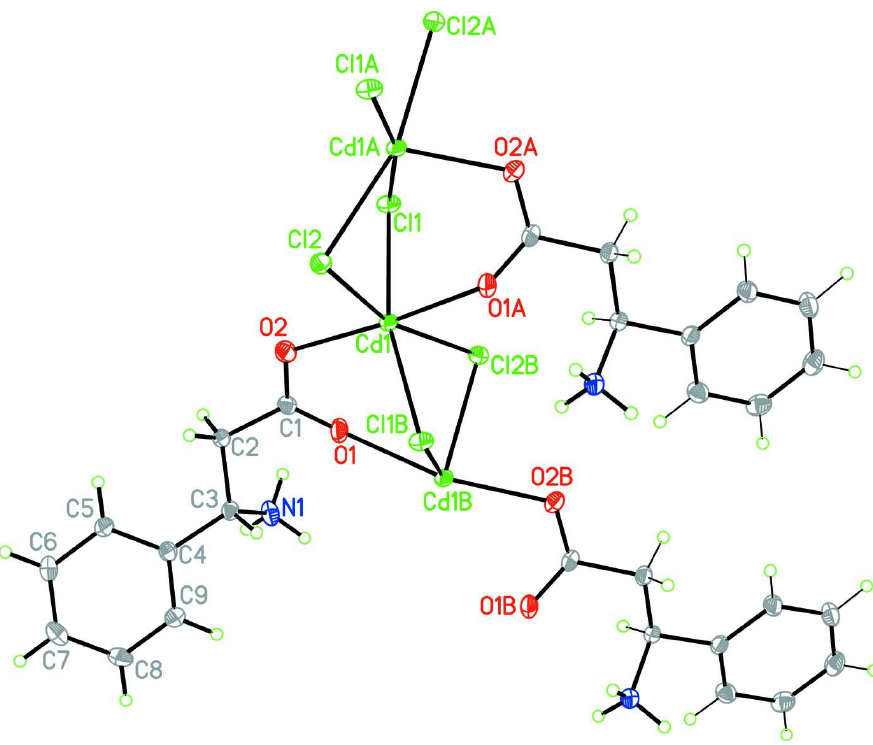
Figure 1 A partial packing diagram of the title compound, with the displacement ellipsoids were drawn at the 30% probability level. [Symmetry codes: (A) - x +1, y - 1/2, - z + 3/2; (B) - x + 1, y + 1/2, z +